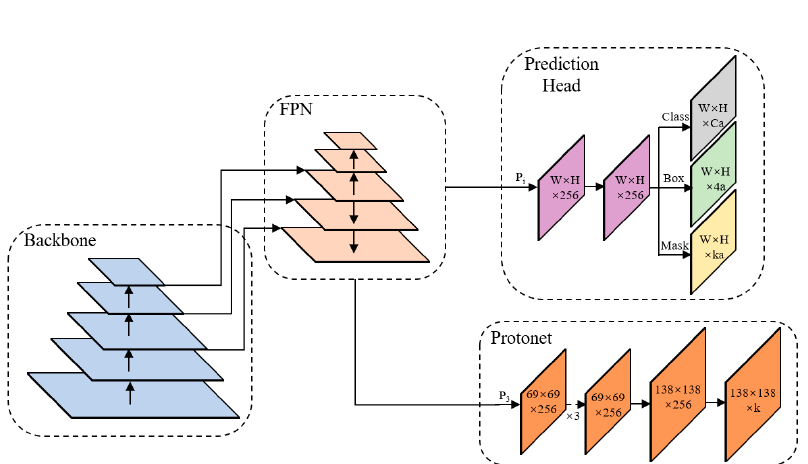
Figure 6. The four parts of the YOLACT segmentation model.